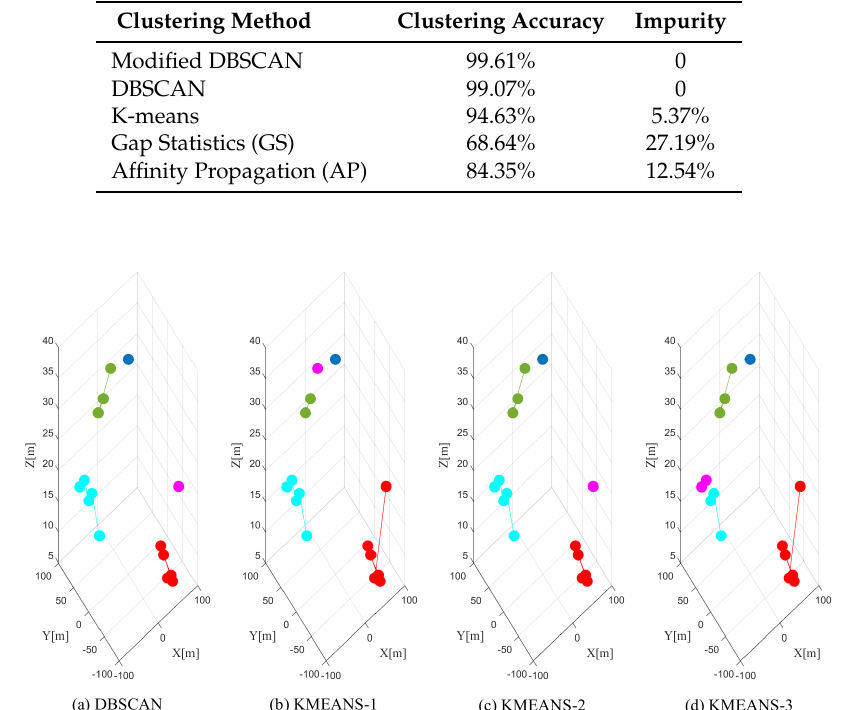
Figure 7. The clustering performance of DBSCAN and